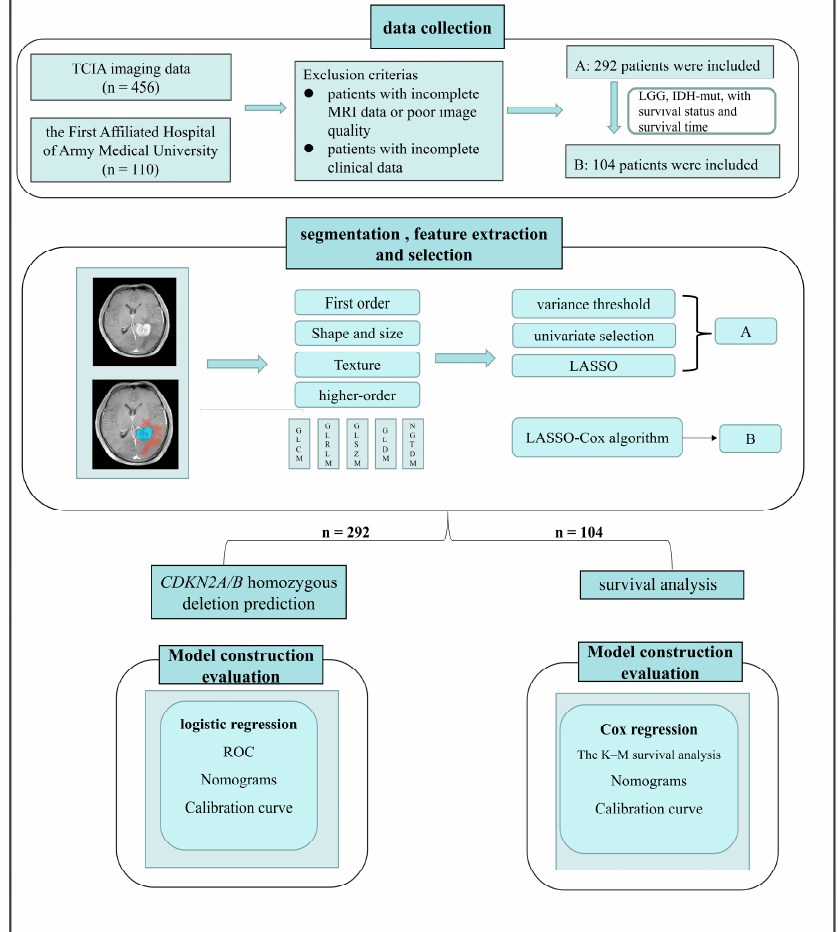
Figure 1. Work fl ow of this study: A means the project of CDKN2A/B homozygous deletion predic- Figure 1. Workflow of this study: A means the project of CDKN2A/B homozygous deletion prediction. tion. B means the project of survival analysis. B means the project of survival